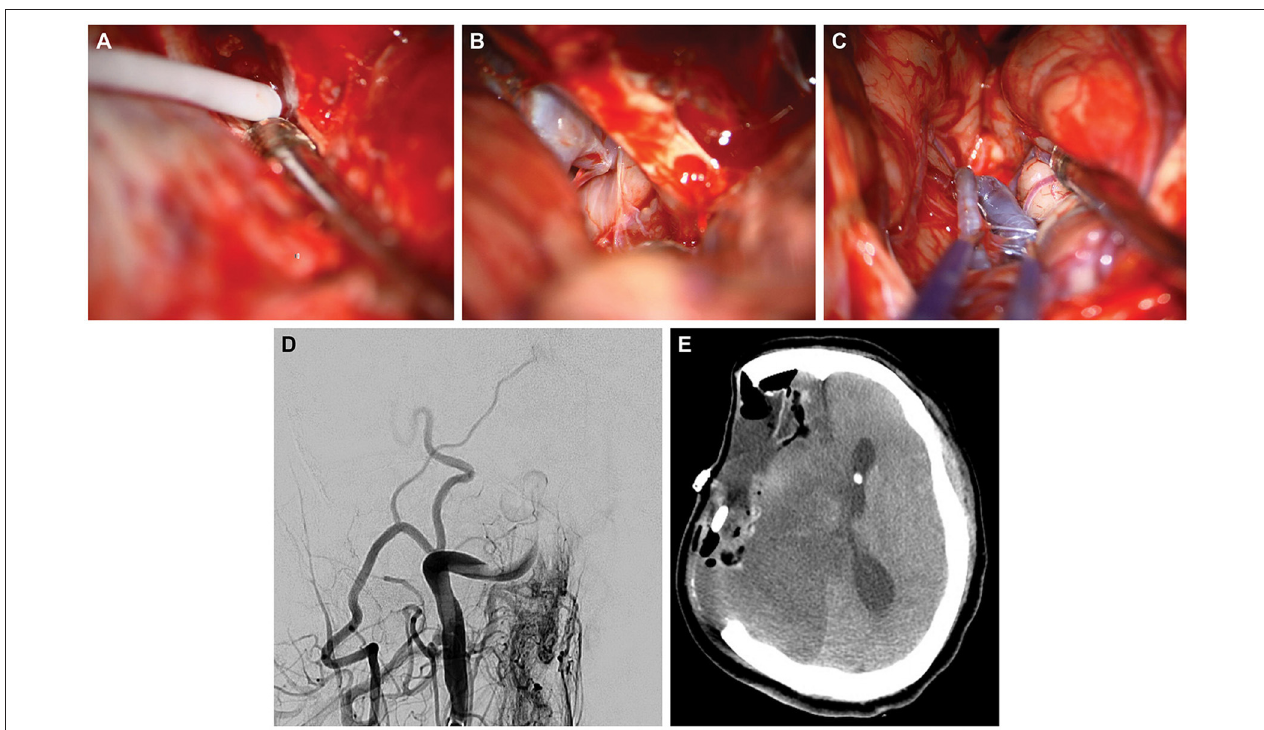
FIGURE 2 | Case 2. Intraoperative photographs demonstrating (A) direct injection of fibrin glue into the cavernous sinus; (B) subsequent visualization of the patent internal carotid artery (ICA) during resection; and (C) 90min later, the thrombosed middle cerebral artery, which has turned blue. (D) Postoperative posteroanterior angiography via the right common carotid artery demonstrating occlusion of the distal ICA. (E) Postoperative axial computed tomography of the head after decompressive hemicraniectomy and resection of ischemic territory. Used with permission from Barrow Neurological Institute, Phoenix,